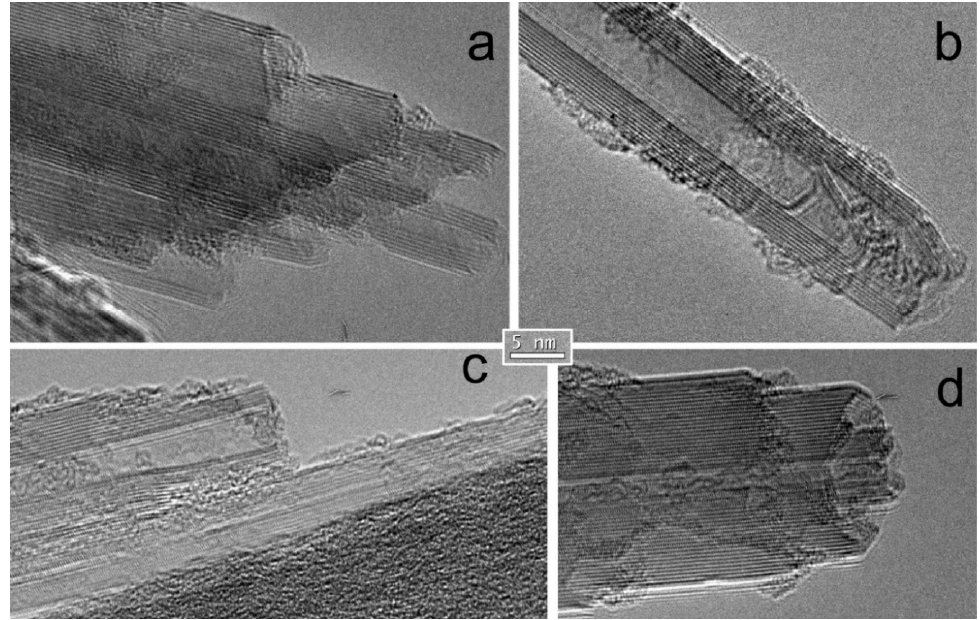
Figure 2. HRTEM images of ends of oxidised (in TGA), arc-prepared MWCNTs from the same commercial batches as in Figure 1: ( a , b ) from MER Corporation; ( c , d ) from Sigma Aldrich.